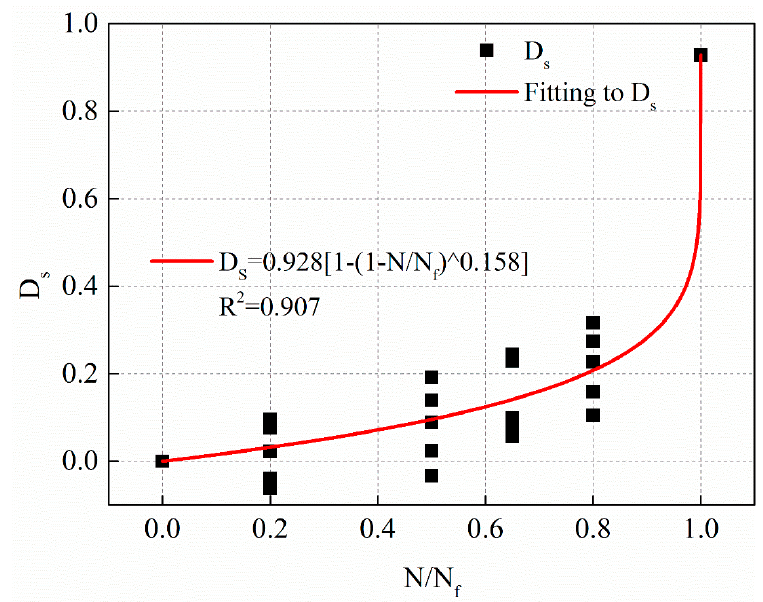
Figure 20. The fatigue damage evolution curve based on residual strength decay with stress levels of 0.25 MPa.